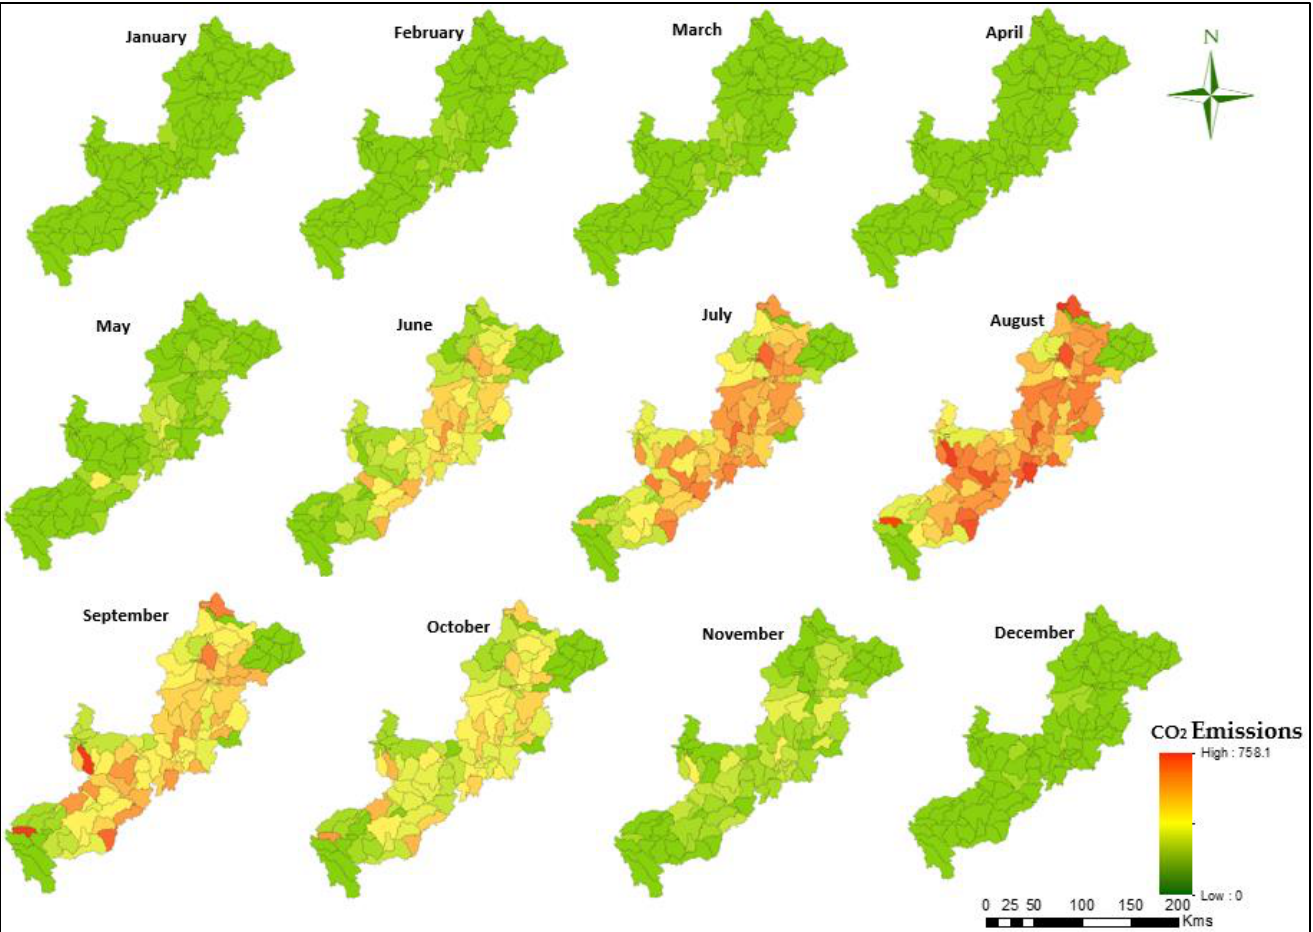
–2 day –1 ). µ mol CO 2 Emissions ( 2 –C m